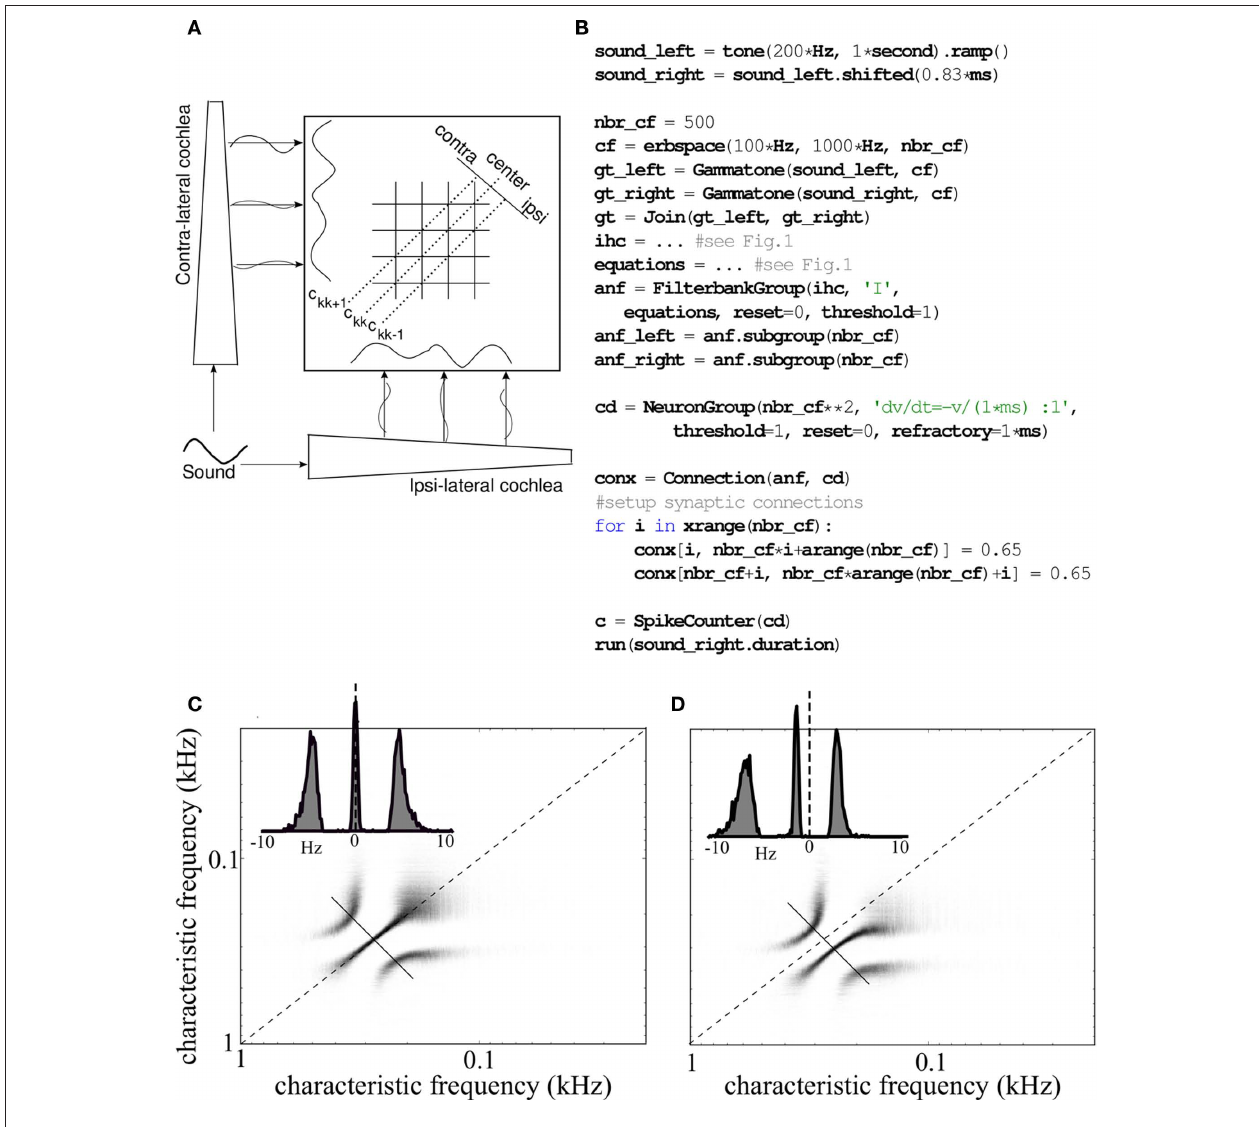
the ipsilateral input, vertical: CF of the contralateral input) in response to a 500-ms tone at 200 Hz presented simultaneously at both ears. The inset shows spike counts along the short diagonal line, as a function of CF difference between the two inputs. (D) Same as (C) but with the tone shifted by 830 μs at the contralateral